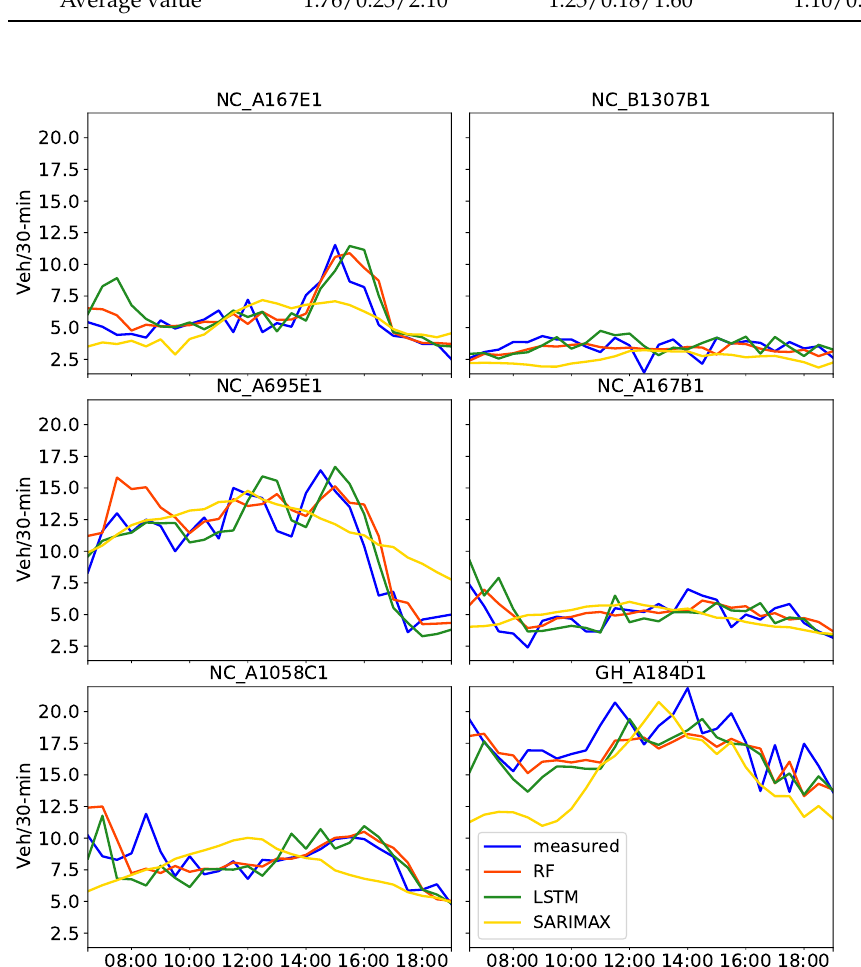
Figure 8. Predictions on 2 August 2019 obtained with three tuned models, RF, LSTM and SARIMAX, using the past four months of training data including four exogenous attributes. Measured traffic volume constitutes the “ground